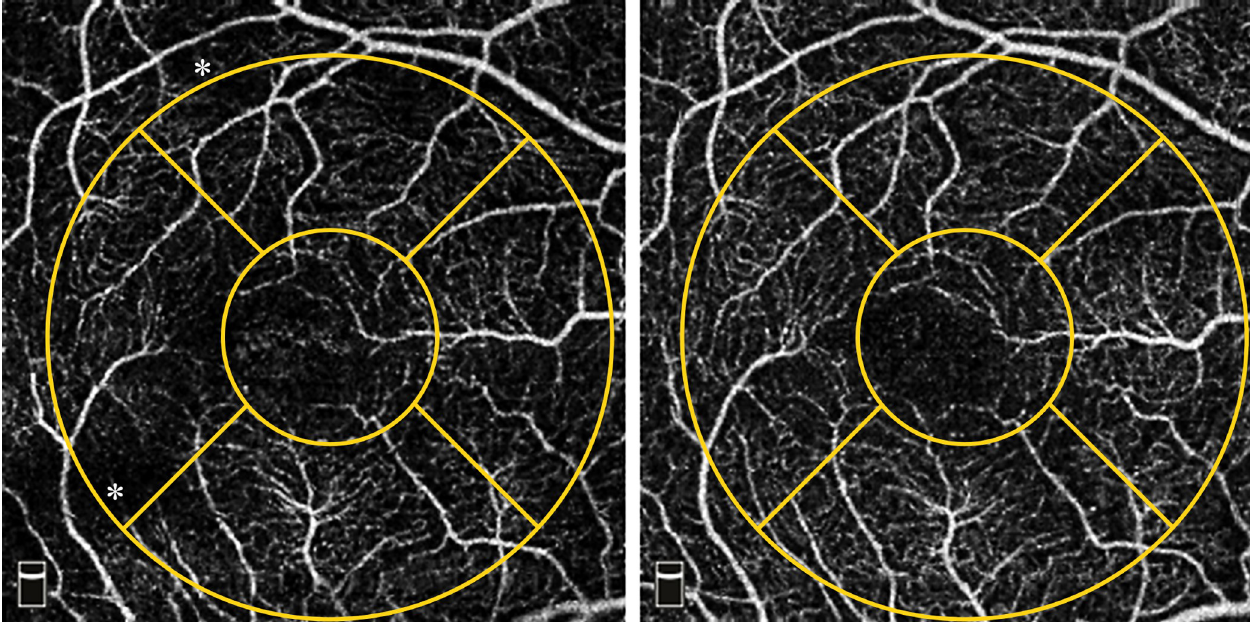
Fig 2. Example of reduction of artifacts evaluated by motion artifact score (MAS) before (A1) and after (A2) pupil dilation. A1 shows a MAS of 2 with slight-moderate quilting (examples marked with asterisks), A2 shows a MAS of 1: no quilting, absence of all other artifacts. Asterisks: focal changes in flow density (FD) in regions where artifacts are present.